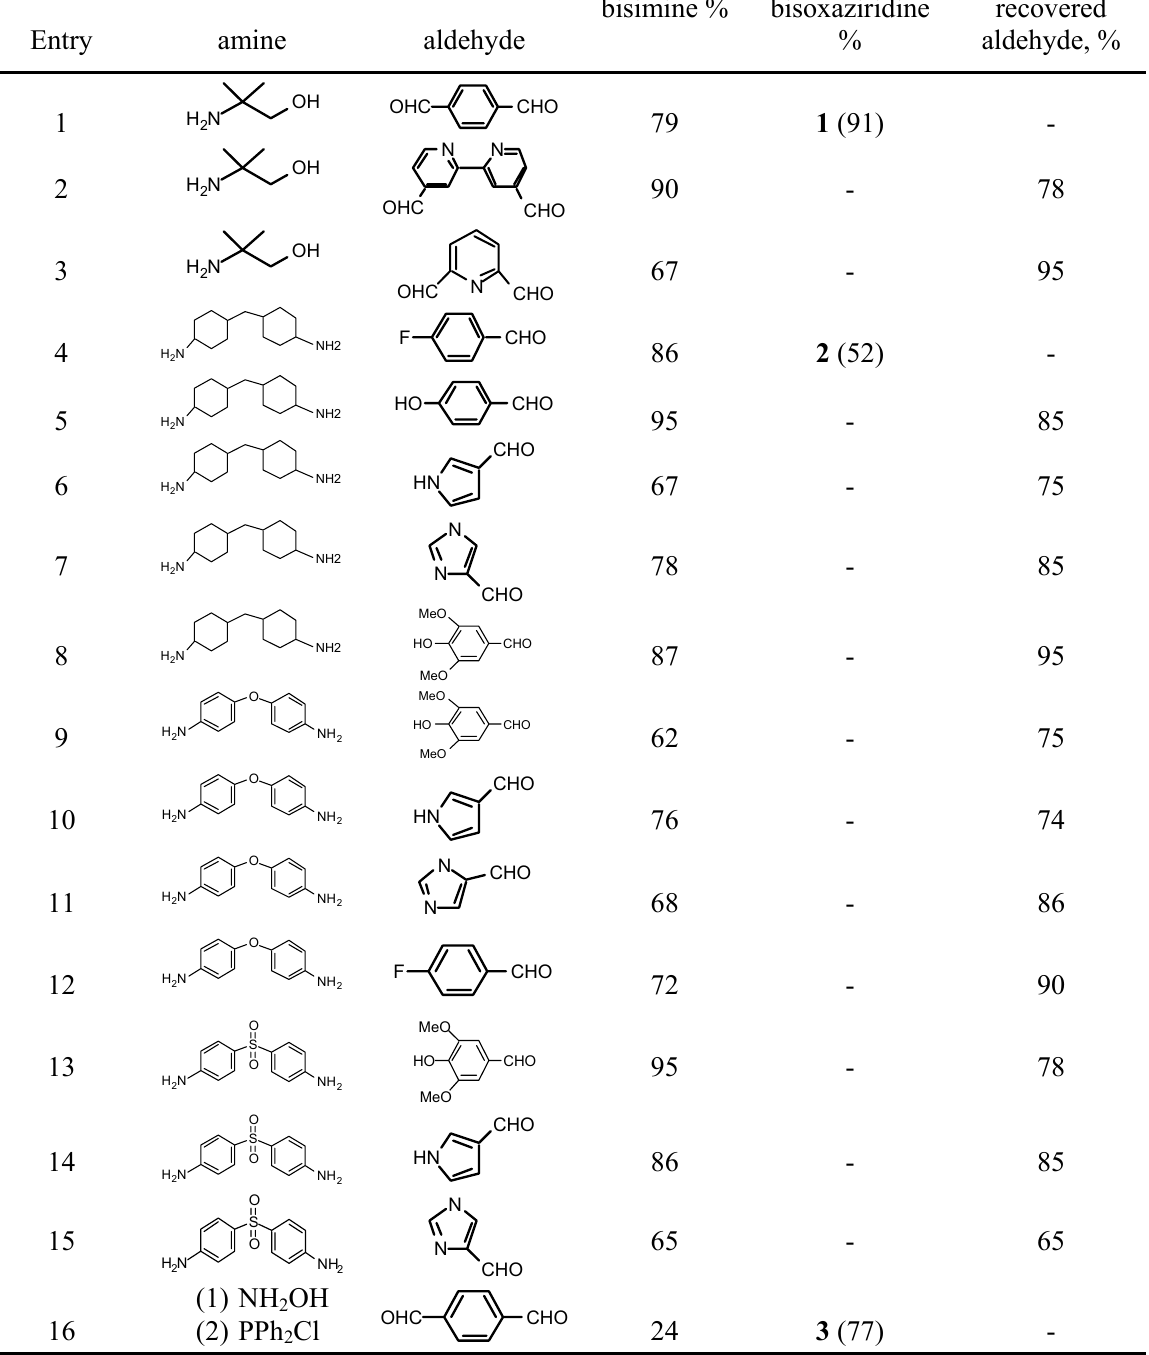
Table 1. Synthesis of